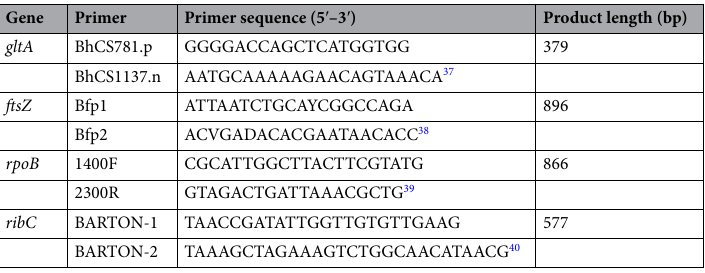
Table 4. The primers used in this